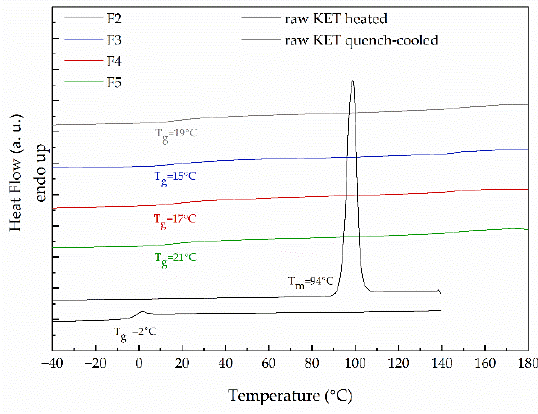
Figure 5. DSC thermograms of raw KET and filaments containing 40% of KET with the addition of various disintegrants.